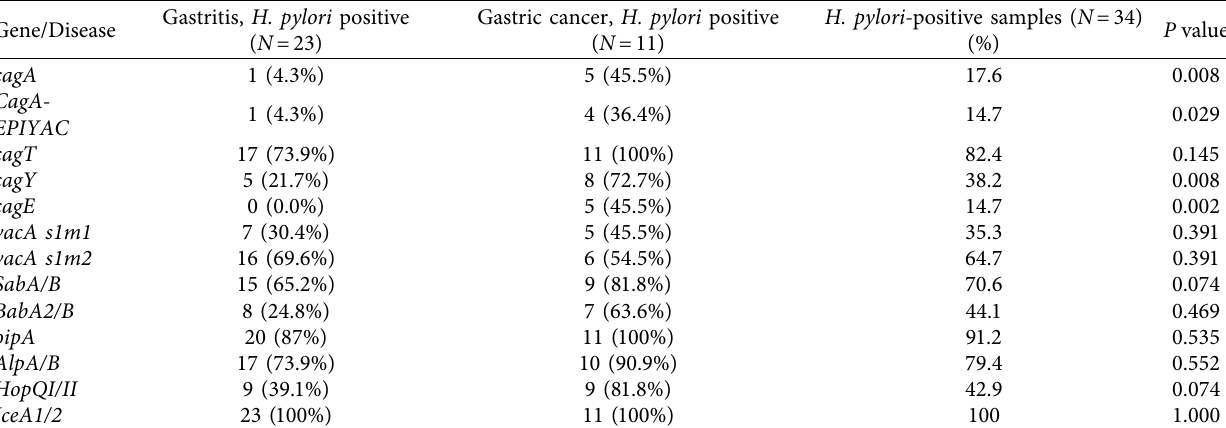
Table 4: Frequency of H. pylori virulence genes’ cDNA in biopsy samples of gastric and gastric carcinoma patients with H. pylori infection. Gastritis, H. pylori Gene/Disease